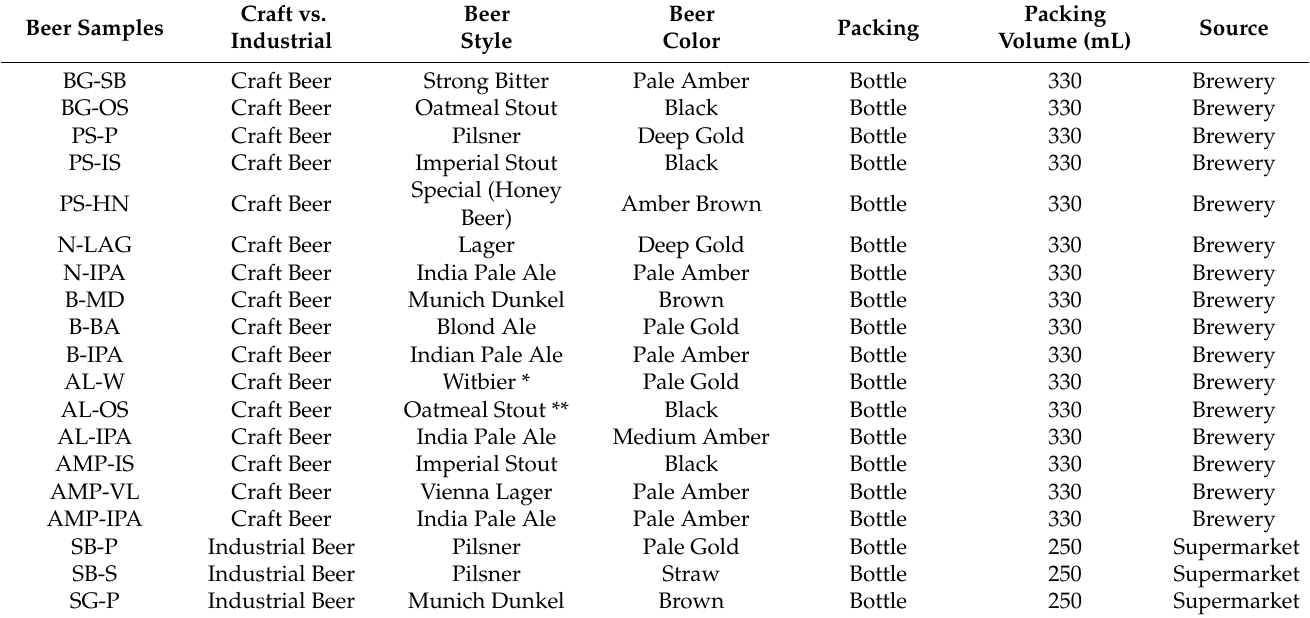
Table 6. Characteristics of each beer sample regarding its production, packaging type and